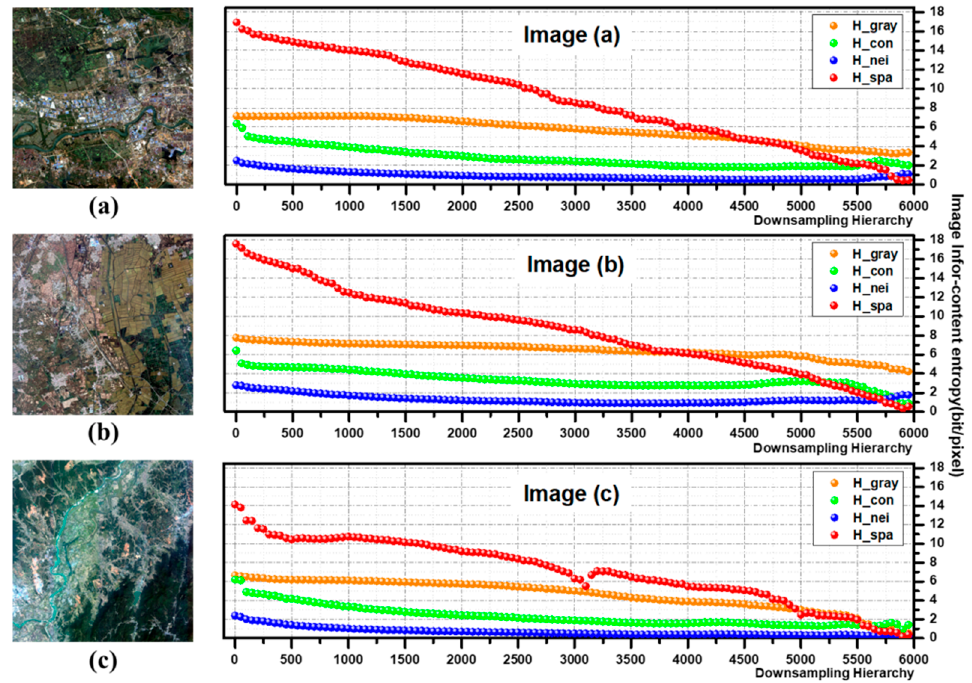
Figure 10. Changes in image information content at different features during downsampling. The scatter plots image(a),(b) and (c) show the trend of multi-feature information content of three GID high-resolution remote sensing images (a), (b) and (c) during the downsampling process. Table 1. Spearman correlations of the information content of each feature in downsampled images. Features